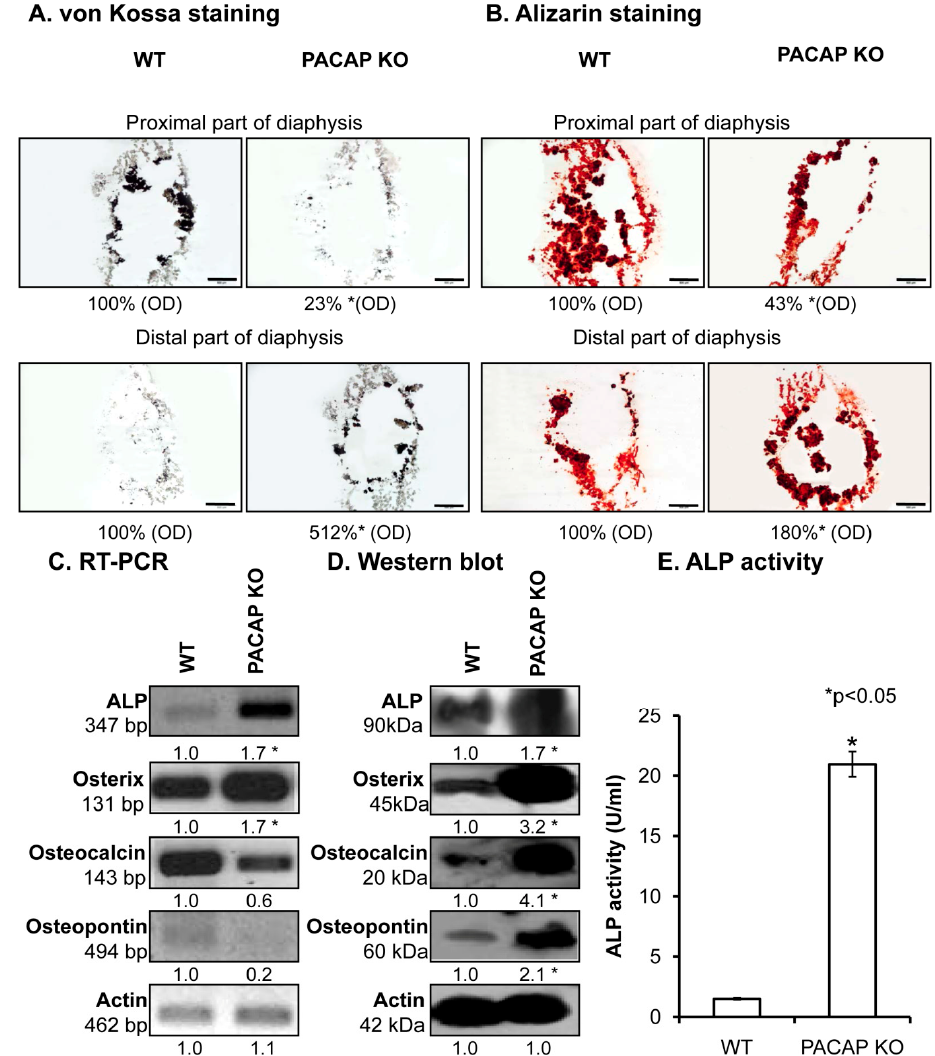
Figure 2. Investigation of inorganic matrix production of long bones. von Kossa ( A ) and alizarin red ( B ) staining of cryosectioned samples. Original magnification was 4×. Scale bar: 500 µm. Optical density (OD) was determined in microphotographs and normalised to wild type samples. mRNA ( C ) and protein ( D ) expression of alkaline phosphatase (ALP), osterix, osteocalcin and osteopontin of femurs. For reverse transcription followed by polymerase chain reaction (RT-PCR) and Western blot reactions, actin was used as control. Optical signal density was measured and results were normalised to the controls. For panels ( C , D ) numbers below signals represent integrated signal densities determined by ImageJ software. ( E ) ALP activity in compact bone. Asterisks indicate significant (* p < 0.05) alteration of ALP activity compared to the respective control. Representative data of 3 independent